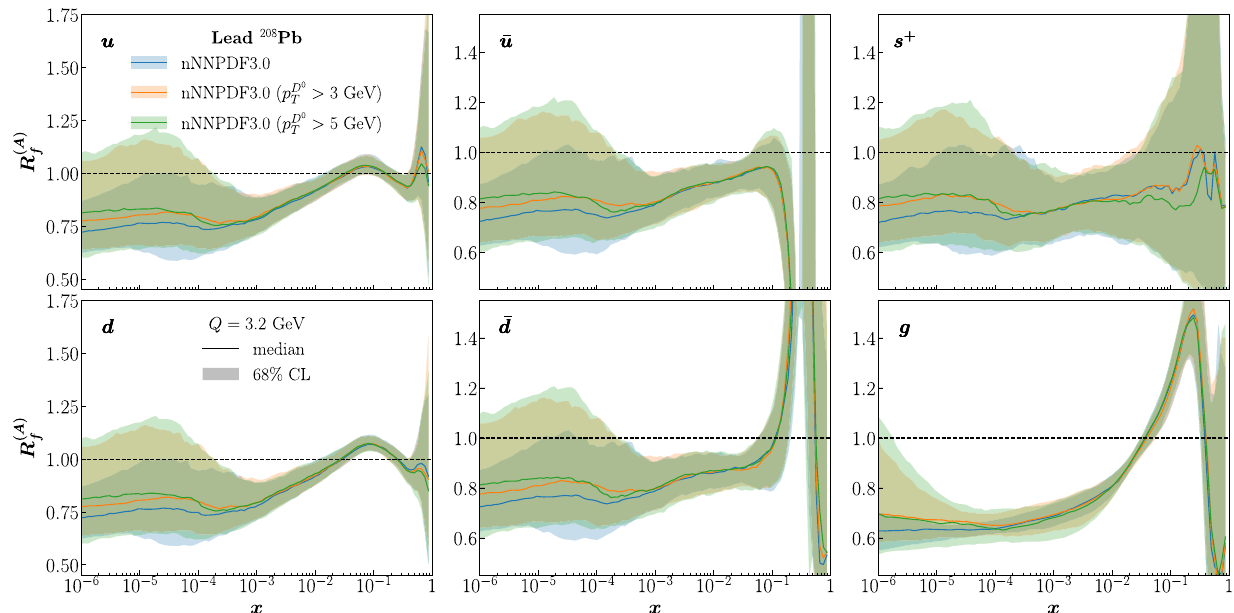
Fig. 24 Same as Fig. 10, now at Q 2 = 10 GeV 2 , comparing the baseline nNNPDF3.0 determination with the variants where kinematic cuts of ≥ 3 GeV and p D 0 ≥ 5 GeV are applied to the LHCb D 0 -meson cross-section data, see also Table p D 0 T T